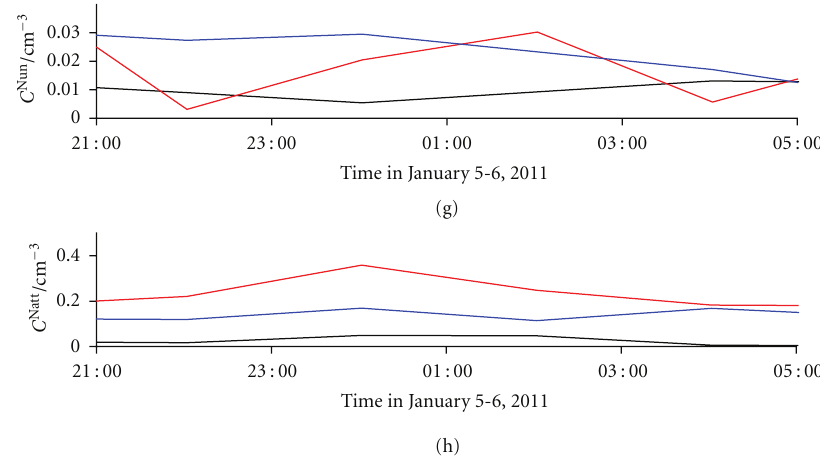
Figure 19: Time run of: (a) total number concentration of general aerosol particles ( C N (tot)) and geometric mean values of their diameters gen ( d GM ), (b) activity concentration of radon ( C A ) and equilibrium equivalent activity concentration of radon decay products ( C A ), (c) Rn RnDP number fraction of particles smaller than 10 nm ( x gen ( < 10)) and smaller than 20 nm ( x gen ( < 20)), (d) activity fraction of the unattached RnDP , C Aun 214 , and ( f un ) and number fraction of the unattached RnDP ( x un ), (e) activity concentrations of the unattached RnDP atoms ( C Aun 218 Pb Po C Aatt C Aatt C Aatt C Aun 214 Bi ), (f) activity concentrations of the attached RnDP atoms ( 218 Po , 214 Pb , and 214 Bi ), (g) number concentrations of the unattached , C Nun 214 , and C Nun 214 ), and (h) number concentrations of the attached RnDP atoms ( C Natt 218 , C Natt 214 , and C Natt 214 ), in RnDP atoms ( C Nun 218 Pb Bi Pb Bi Po Po indoor air for the period January 5-6 (period of burning a candle in the kitchen from 22:23 on January 5 to 1 :50 on January 6).